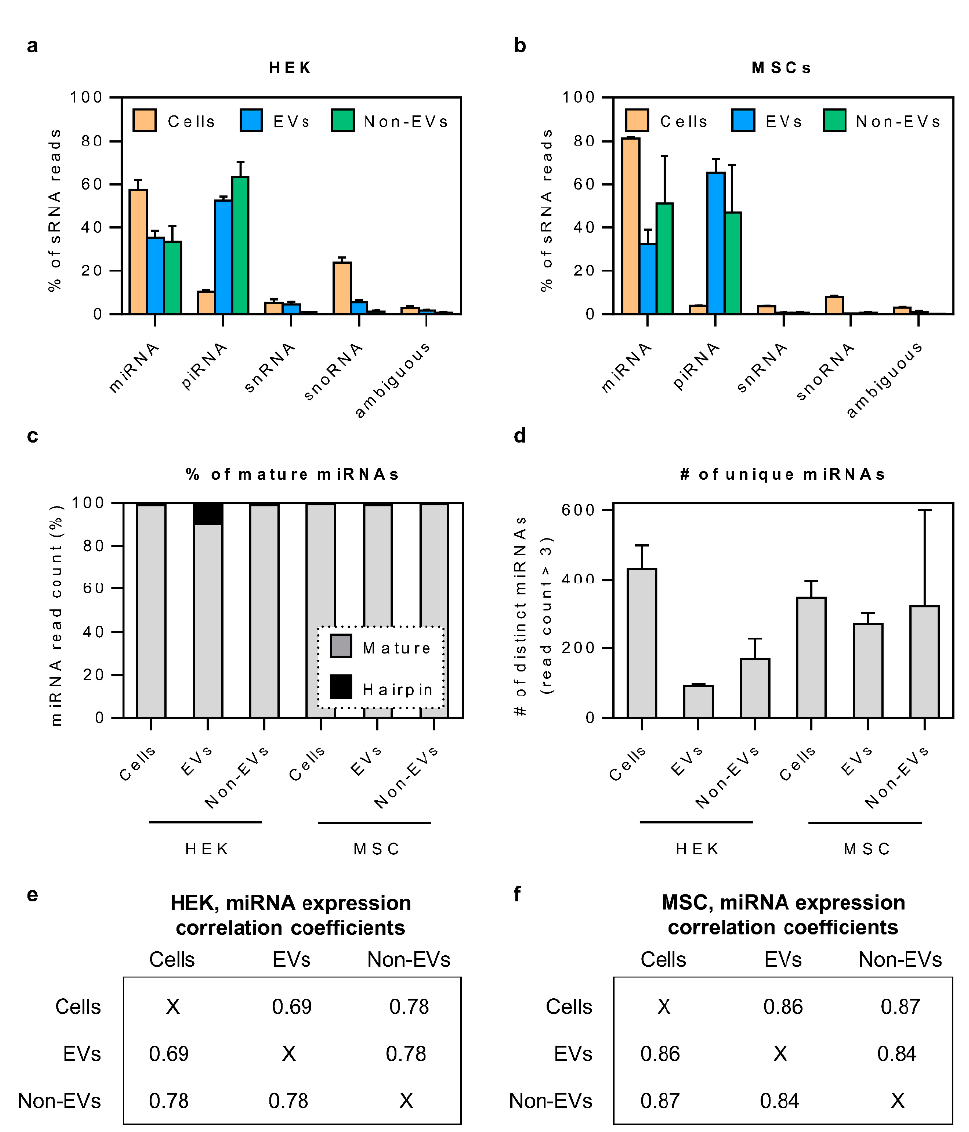
Figure 3. sRNA composition, characteristics and correlation in source cells and secretory fractions.